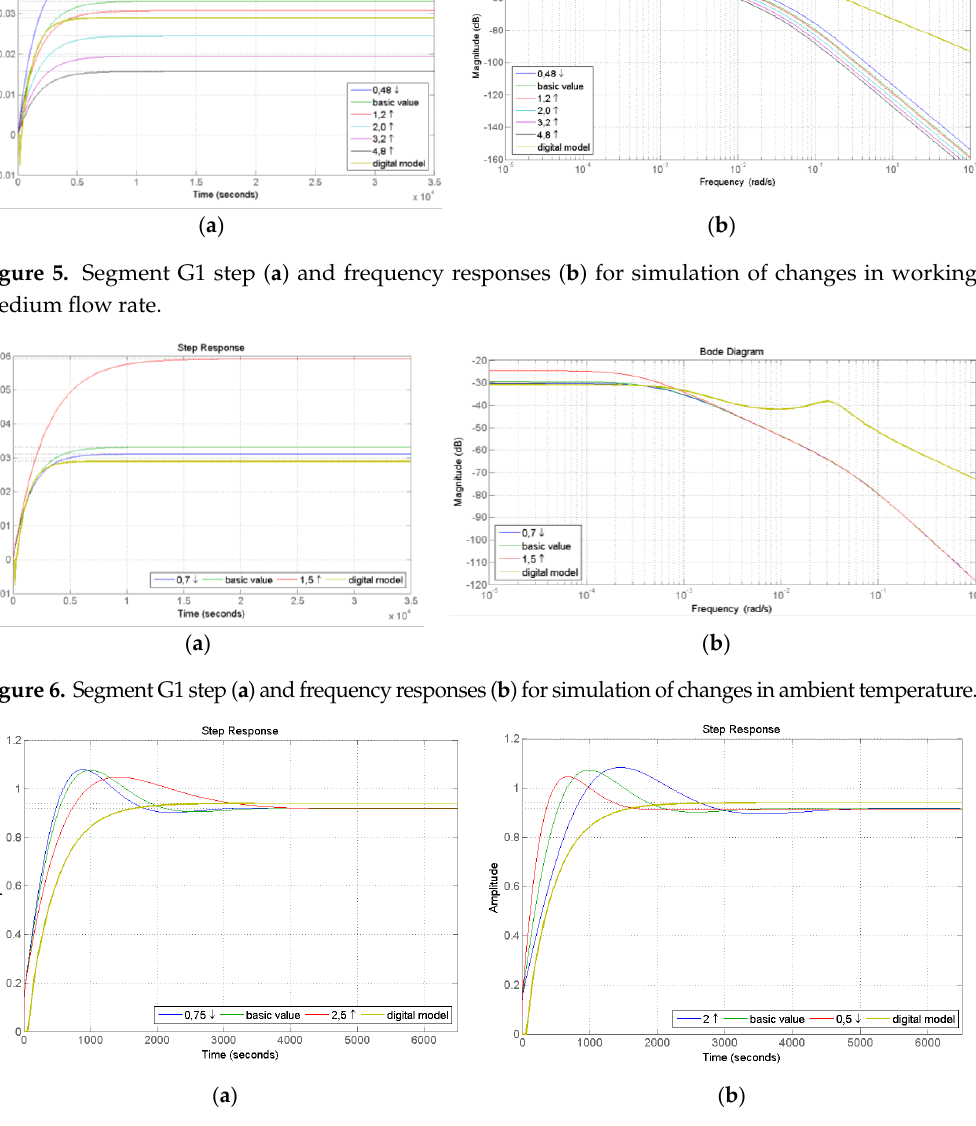
Figure 7. Segment G2 step responses for simulation of changes in thickness of glass ( a ) and thickness of absorber ( b ).